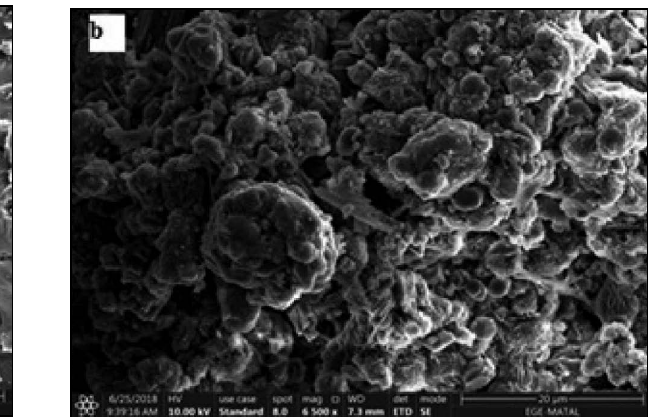
Figure 2. SEM images of bare adsorbents a) SW500 and b)